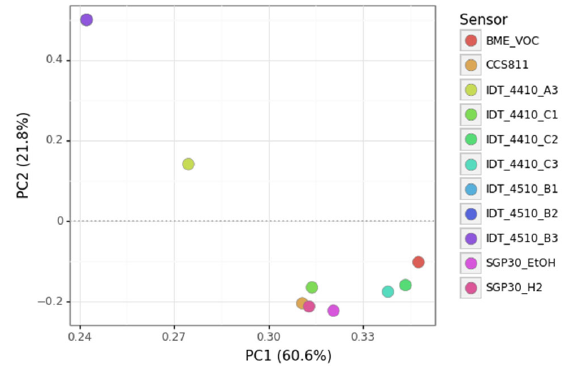
Figure 9. PCA loadings plot.